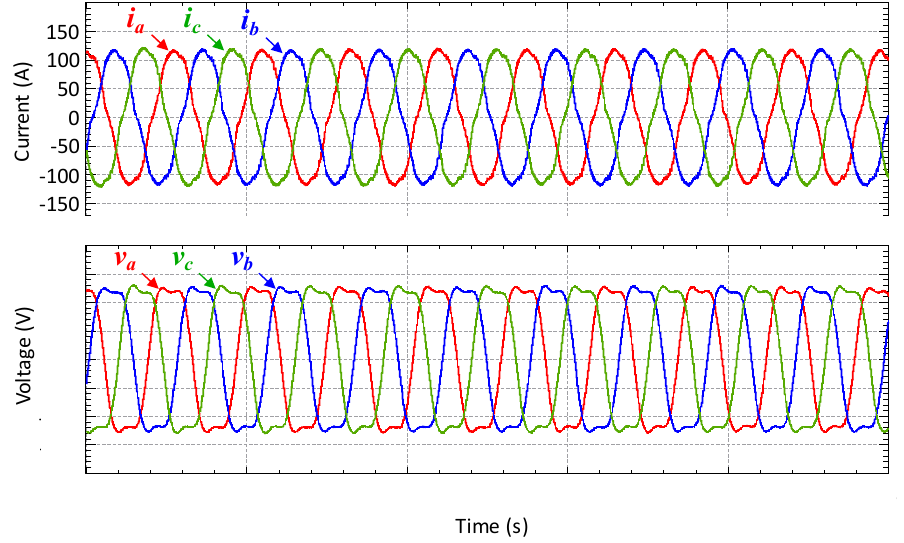
Figure 19. Simulation results of stator voltages and currents in the electric machine for a 50 Nm mechanical load.